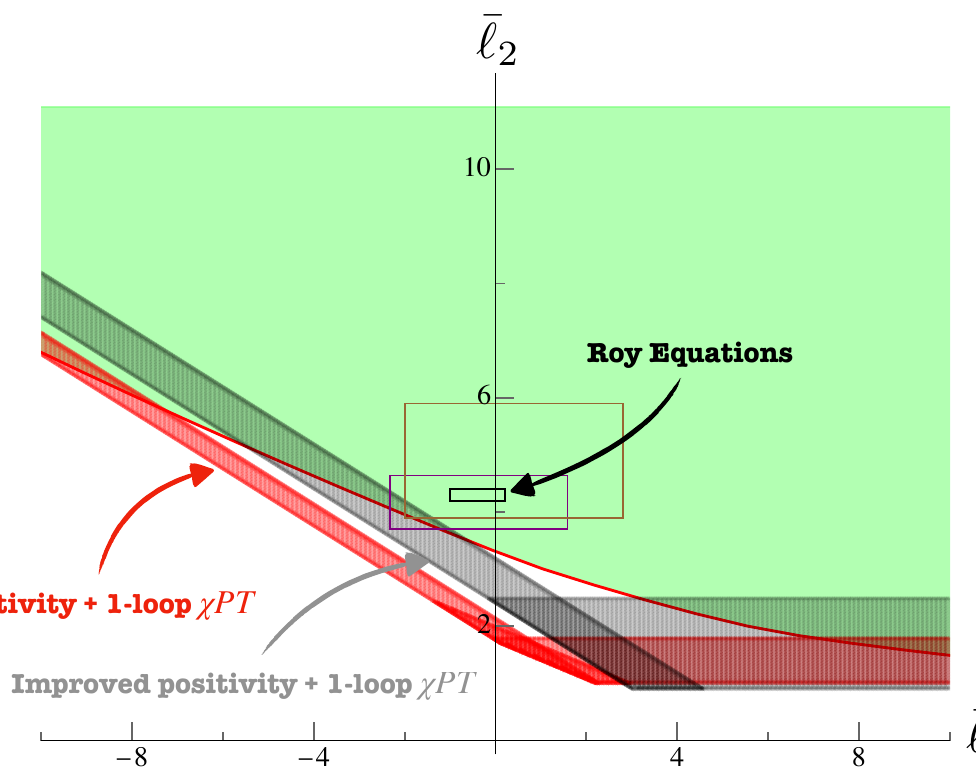
Figure 8 . In green the allowed region for the low energy constants ¯ ‘ 1 , 2 as determined only by crossing, analyticity and unitarity equipped by pion soft theorem. The red solid line is the boundary of the allowed region for N max = 24 . The red strip represent the result obtained in [12] using positivity properties and in gray we show the improved positivity bounds found in [13]. The colored rectangles correspond respectively to the phenomenological estimates given in [19] (brown), [20] (purple), and [21]